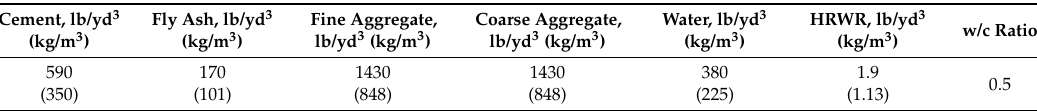
Table 3. Concrete shell mixture properties.